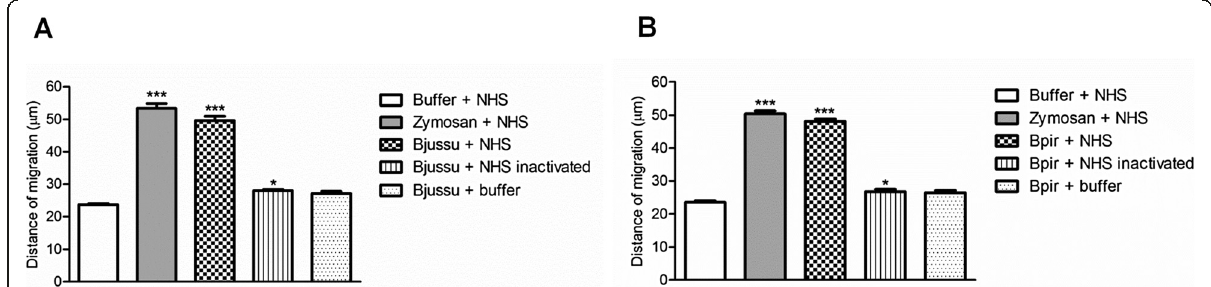
Fig. 3 Chemotactic response of neutrophils to serum treated with ( a ) Bjussu and ( b ) Bpir crude venom. Normal human serum (NHS) was treated with crude venom, zymosan (positive control), or TEA-Ca 2+ -Mg 2+ buffer (negative control). Crude venoms were also incubated with TEA-Ca 2+ -Mg 2+ buf- fer alone or heat-inactivated NHS. Data are expressed as the mean ± standard deviation of three independent experiments assayed in duplicate. * p < 0.05 or *** p < 0.0001 vs. negative control. Bjussu: Bothrops jararacussu ; Bpir: Bothrops pirajai